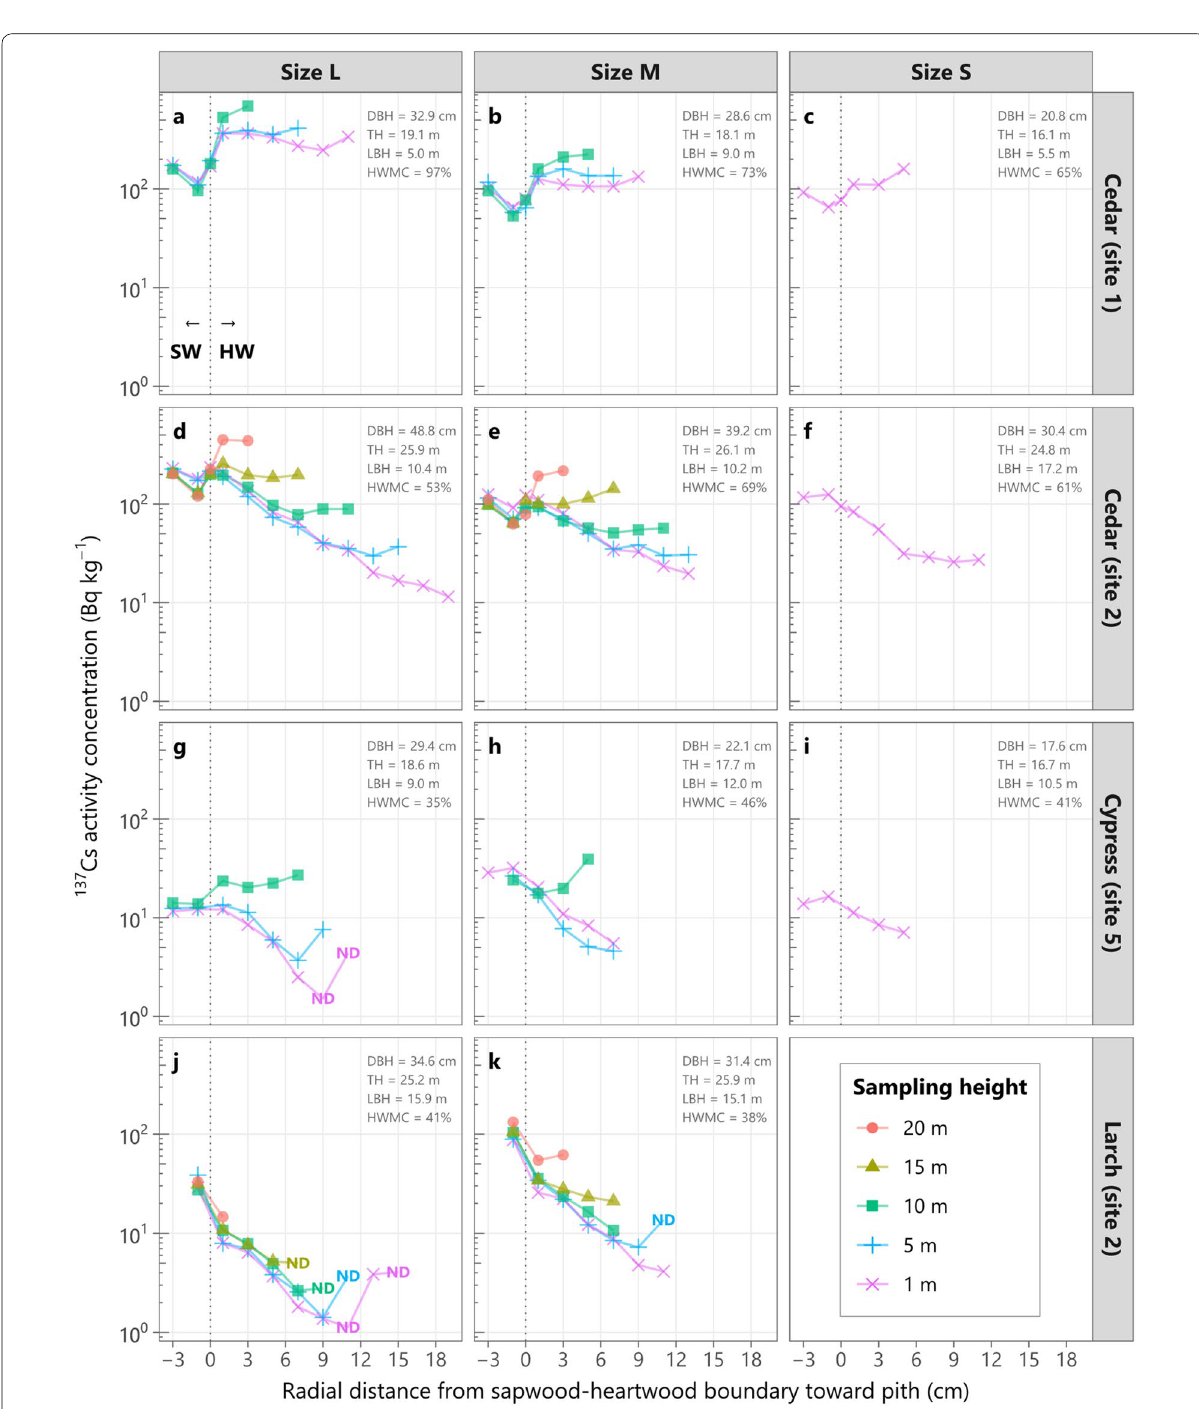
Fig. 2 Radial distribution of 137 Cs activity concentration in wood sampled at different vertical positions in 2014. a – f Japanese cedar ( Cryptomeria japonica ); g – i Japanese cypress ( Chamaecyparis obtusa ); j , k Japanese larch ( Larix kaempferi ). ND letters indicate that 137 Cs activity in the samples was under the detection limit and show the detection limit values. SW sapwood, HW heartwood, DBH diameter at breast height, TH tree height, LBH lowest branch height, HWMC heartwood moisture content (mean moisture content of samples collected at 2.5 and 4.5 m